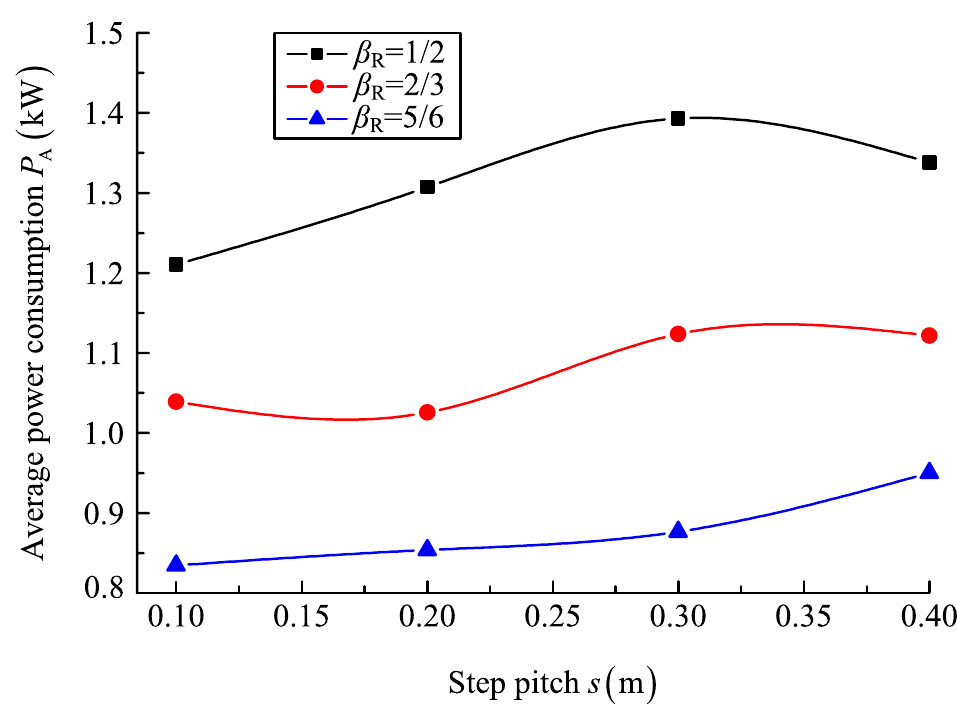
Figure 21 Variation curves of P A with change in step pitch